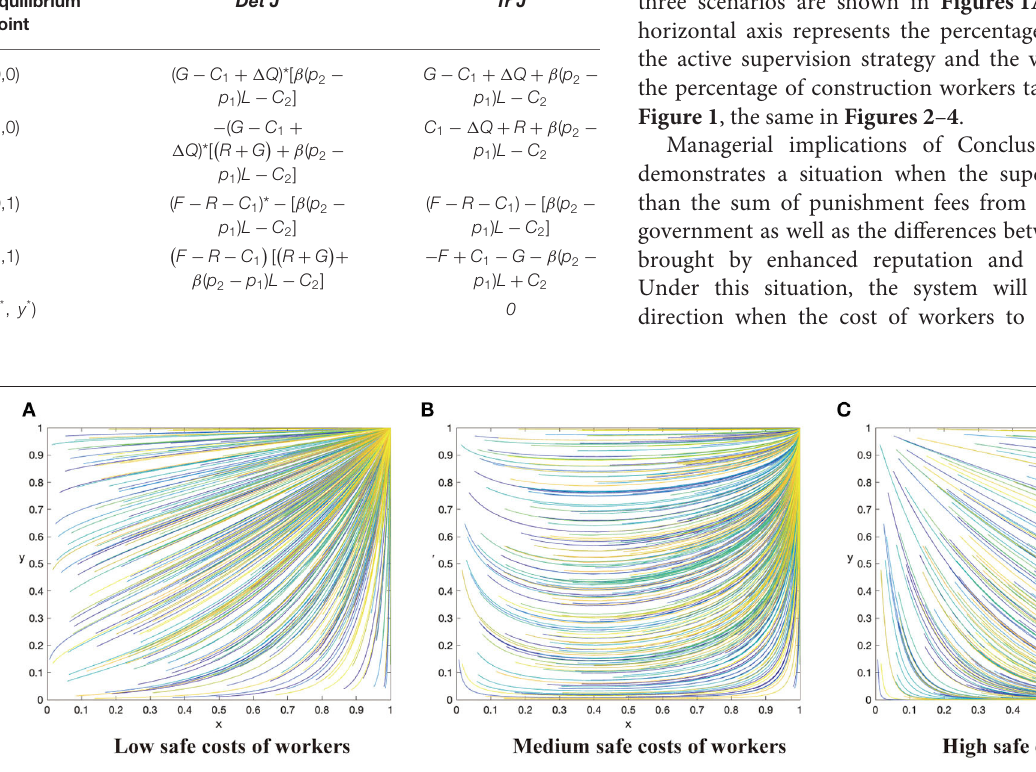
TABLE 3 | The determinant and trace of the Jacobi matrix at different equilibrium point. Equilibrium point